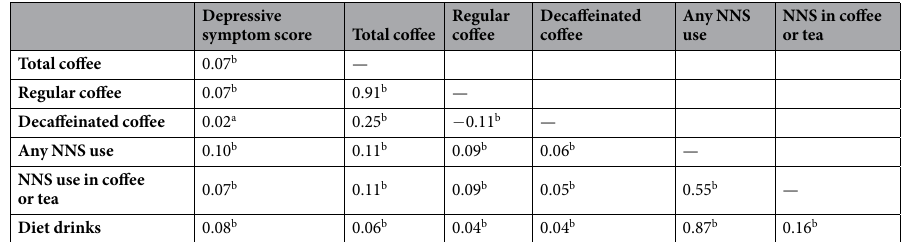
Table 2. Spearman partial correlation coefficients between depressive symptom score, coffee drinking, and non-nutritive sweetener use among study particiapnts * . NNS = non-nutritive sweetener. * Adjusted for age and sex. a P < 0.05, b P <